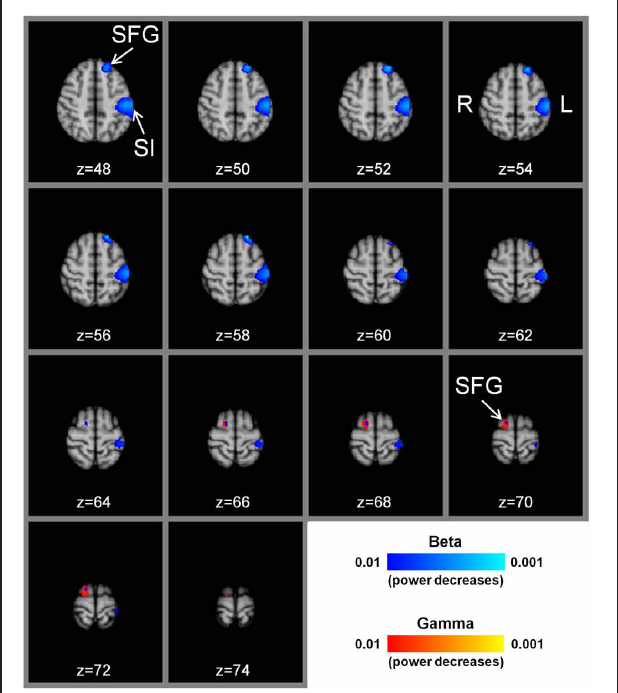
FIGURE 1 | Group t-statistic maps of power reductions in beta and gamma frequency bands with manual acupuncture needling. There are prominent power decreases in the beta frequency band ( P < 0 . 01) in the contralateral left primary somatosensory cortex for the contrast, needle manipulation minus baseline , (needling at acupoint LI-4 in the right hand). There are also significant beta band power decreases in the left superior frontal gyrus ( P < 0 . 01). In the ipsilateral right hemisphere, significant beta and gamma band power decreases are located in the superior frontal gyrus ( P < 0 . 01). The sequential axial MNI152 brain slices are presented in radiological format with the z axis coordinate (mm). SI = primary somatosensory cortex, SFG = superior frontal gyrus, L = left hemisphere, R = right